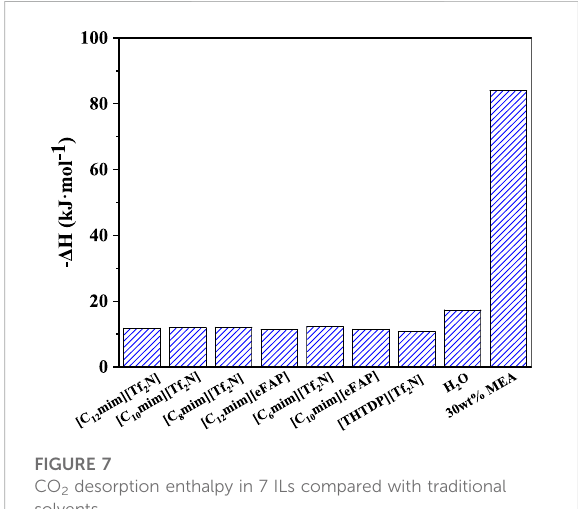
FIGURE 7 CO 2 desorption enthalpy in 7 ILs compared with traditional